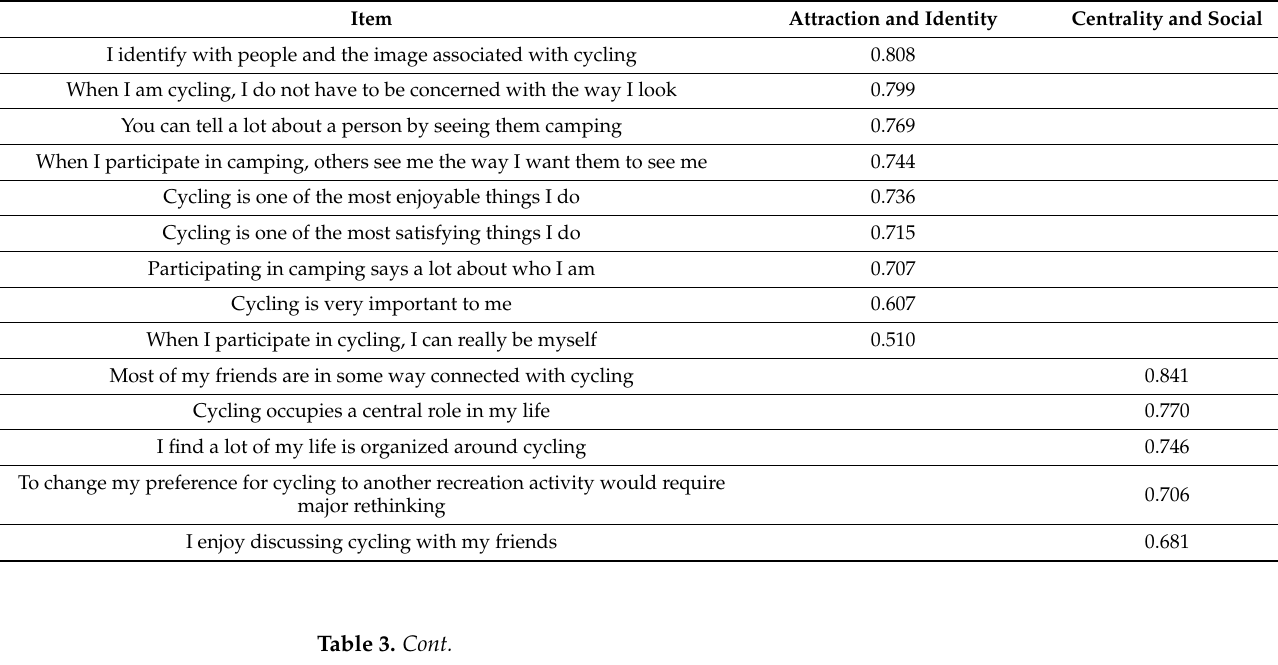
Table 3. Factor analysis of involvement.